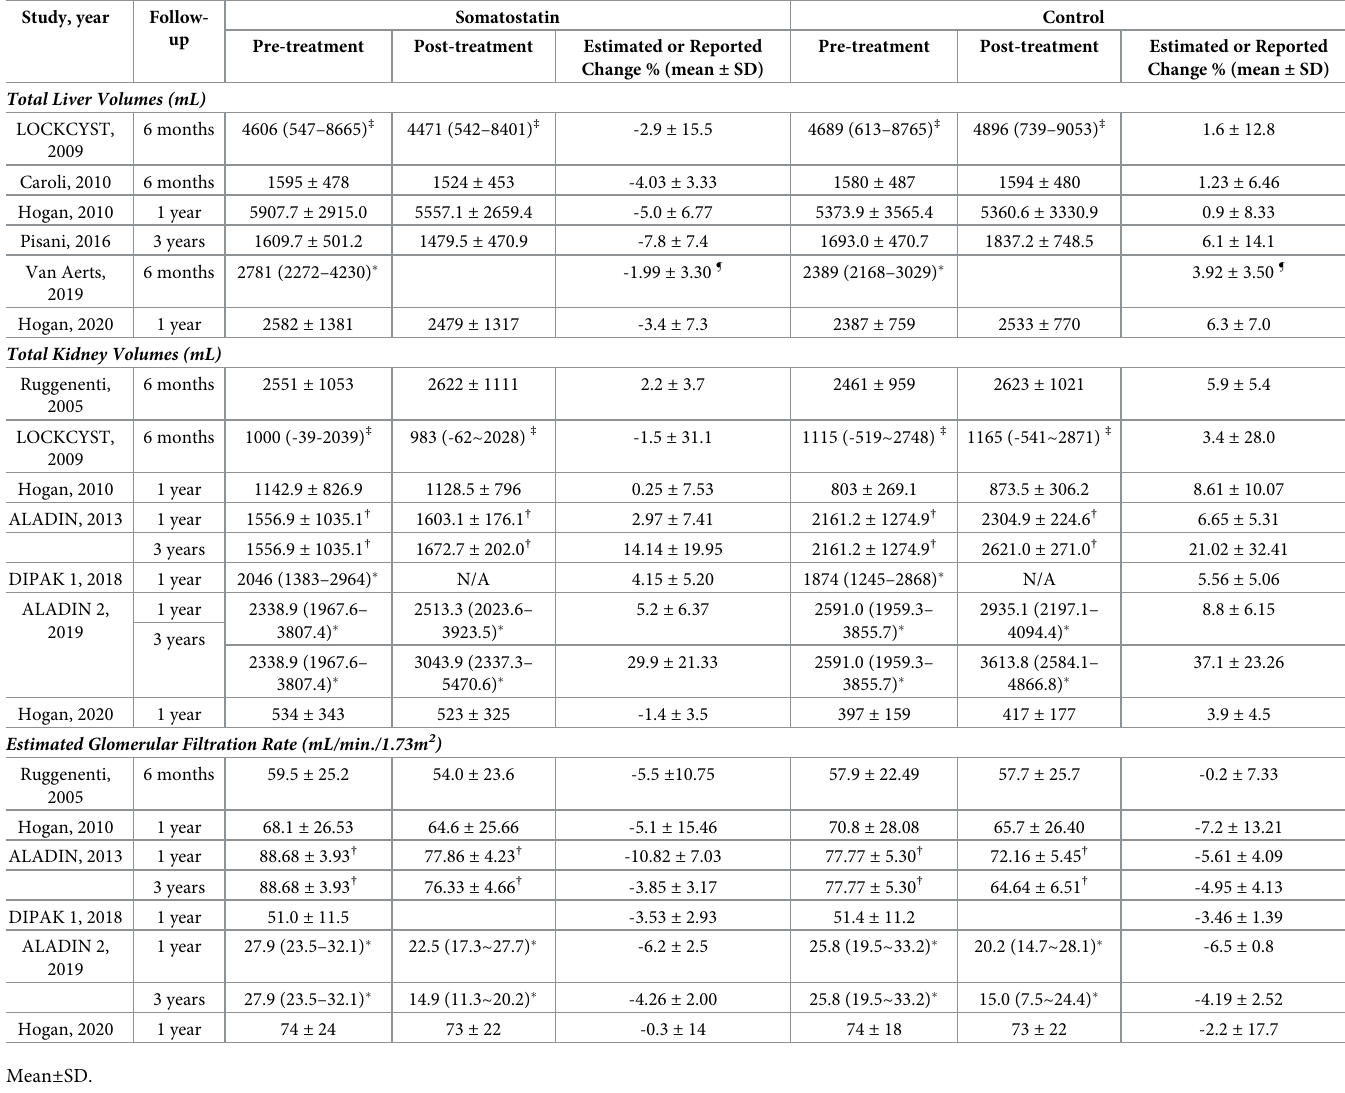
Table 2. Total kidney, liver volumes, and estimated glomerular filtration rate reported in (or estimated from) the included